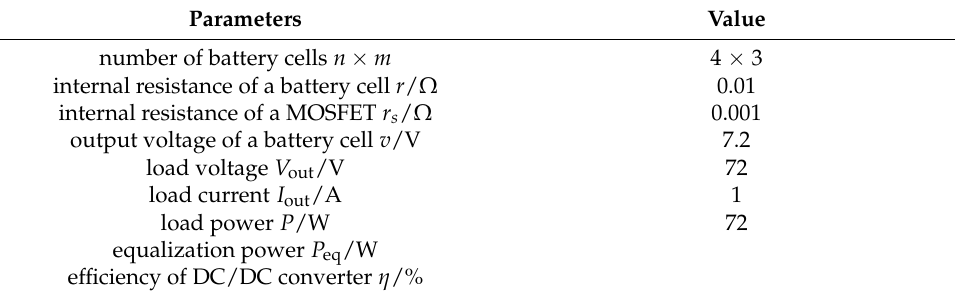
Table 1. The parameters of equalization efficiency calculations.